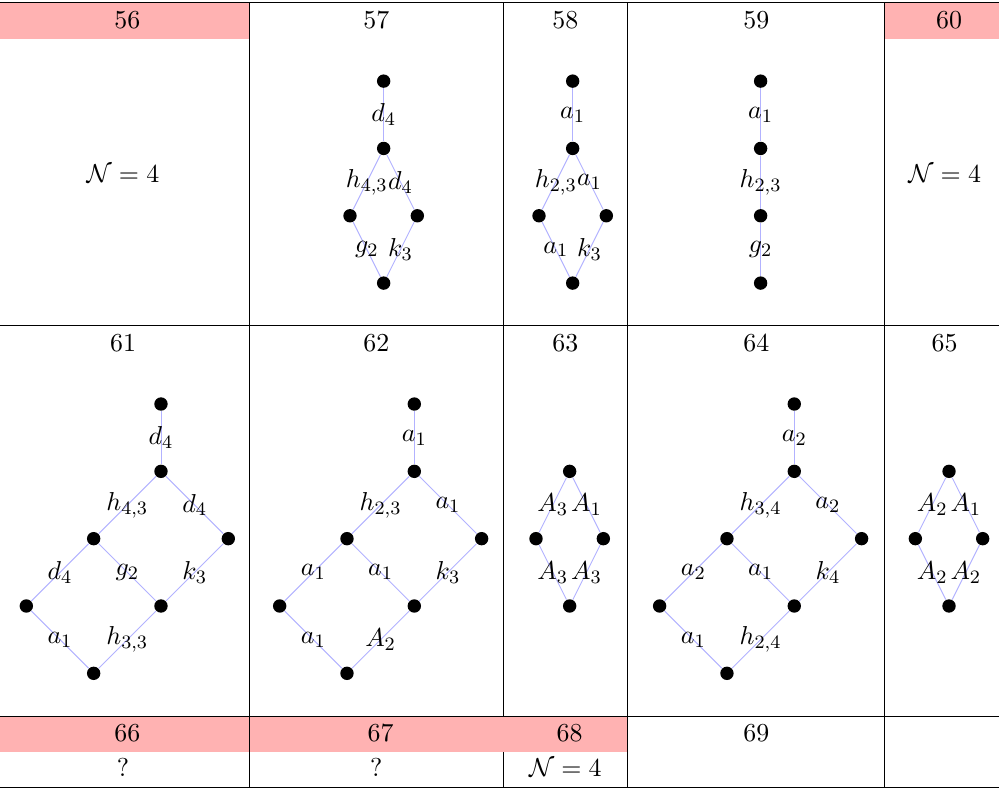
Table 11 . Hasse diagrams deduced from unitary magnetic quivers by quiver subtraction (contin-